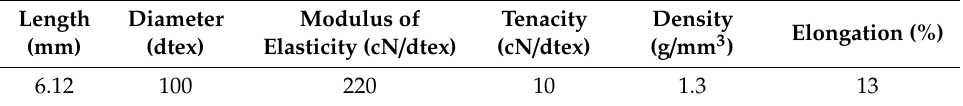
Table 3. Properties of polyvinyl alcohol (PVA) fiber (suggested values by the manufacturer).